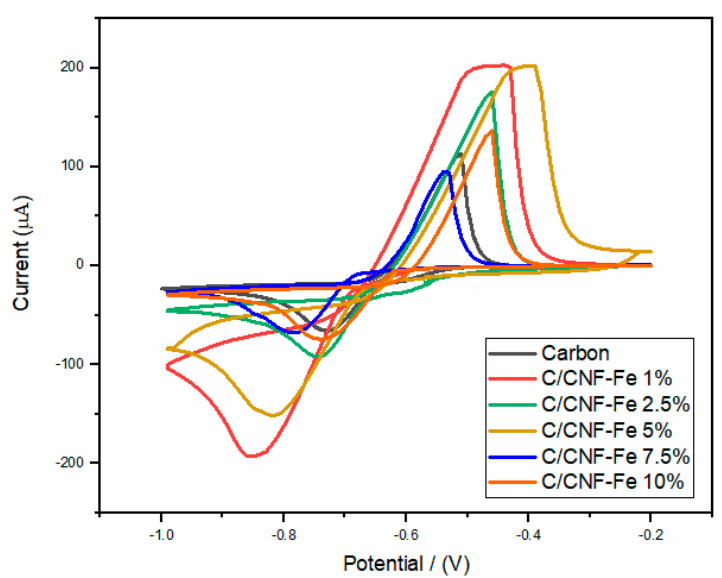
Figure 5. Cyclic voltamogram of a carbon electrode and carbon electrodes modified with CNF-Fe (C/CNF-Fe) at different iron percentages 1%, 2.5%, 5%, 7.5% and 10%, employing a 4.2 pH buffer solution with 100 μ g/L of Pb.